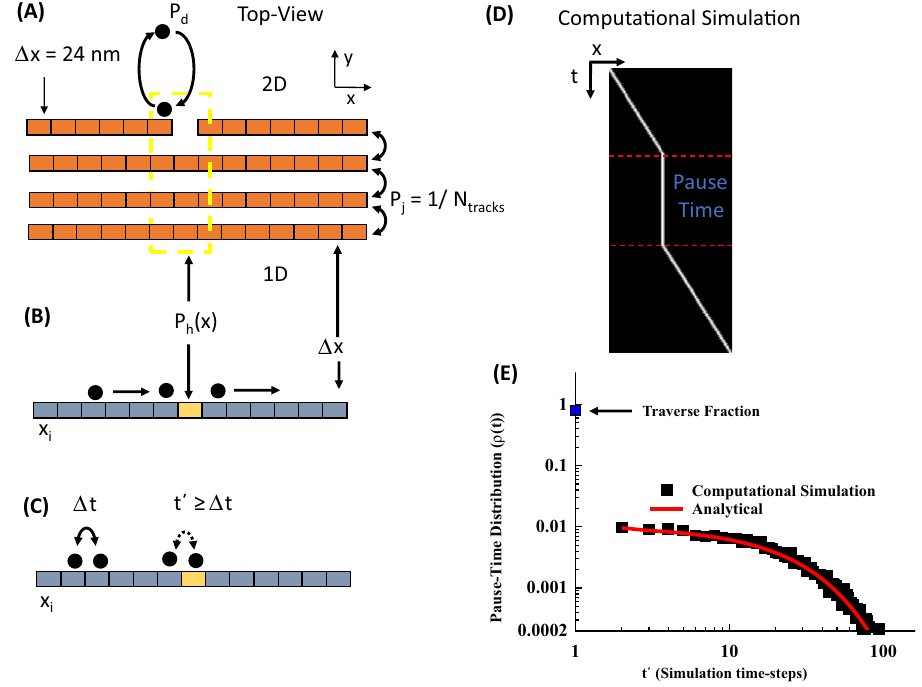
Figure 4. Dominant Motor-driven model. ( A ) We model an axonal bundle as lattice sites along a series of parallel tracks. Vesicles are modeled with a single detachment/attachment parameter (Pd). The probability a motor will jump between tracks is modeled as a uniform probability (Pj). MT-ends are modeled as missing lattice sites. ( B ) We reproduce kymograph results by making a one-dimensional simplification of our two- dimensional model. Each one-dimensional lattice site has the same spatial resolution as the two-dimensional lattice site (Δx). Vesicle inhibition by a MT-end site is now modeled as a probability (Ph), due to the loss of information about which track the vesicle is on. ( C ) The time a simulated SVP pauses at a location with a MT-end (t’) is greater than the time required to transition to the next lattice site (Δt). ( D ) A kymograph representation of a simulated vesicle pausing at the an x-lattice site, but with the exact track location is lost. ( E ) We introduce the Pause-time parameter to quantify and measure the probability a vesicle will pause at a MT-end. We show that our detachment parameter hypothesis (Red-line, Eq. 1) will show a uniform decrease in pause-time with increasing time. We compare our analytical expression with a computational simulation (Black- squares, 1000